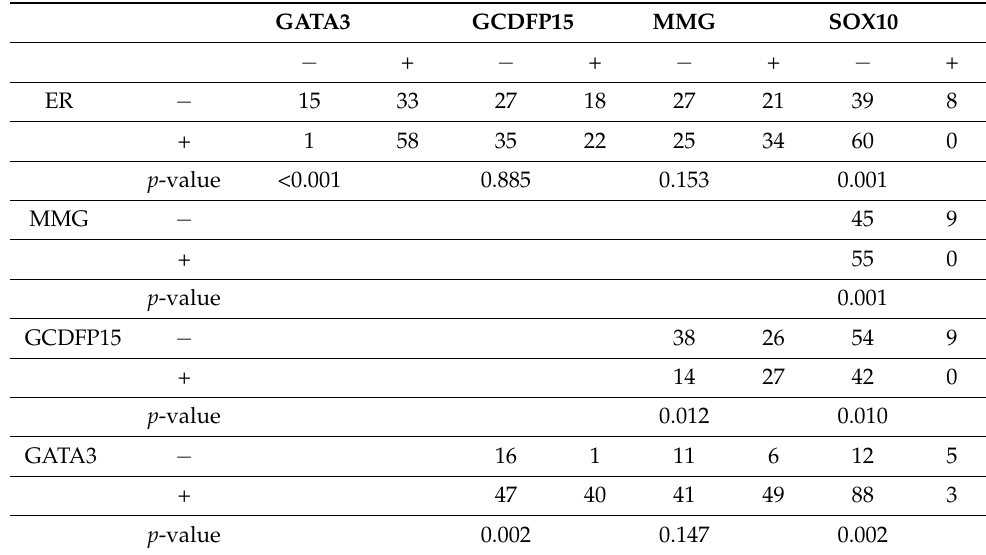
Table 5. Comparison of estrogen receptor (ER), GATA3, gross cystic disease fluid protein-15 (GCDFP15), mammaglobin (MMG) and SOX10 expression with biomarker status.